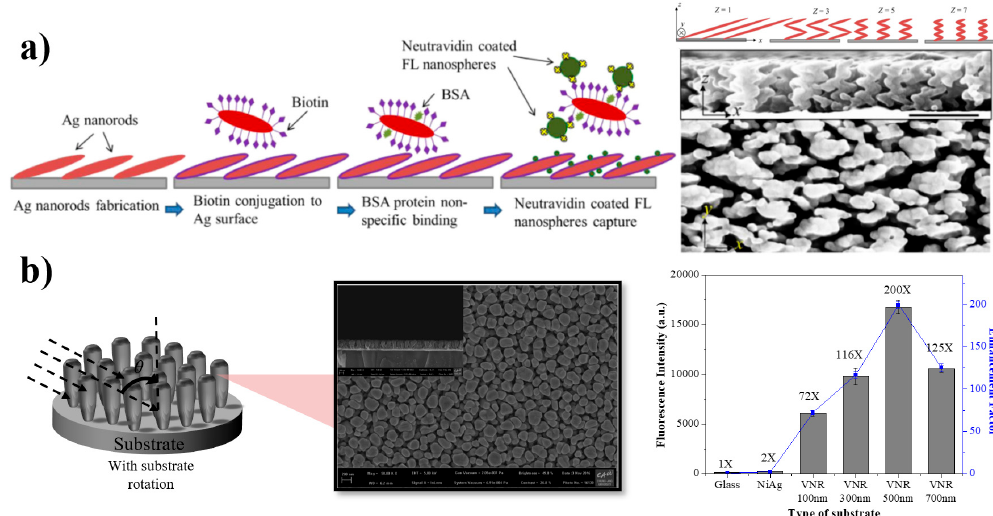
Figure 4. Examples of the MEF substrate fabricated by deposition methods: ( a ) a zigzag nanorods MEF array, and ( b ) a vertical nanorods MEF array. Adapted with permission from references [106][22].